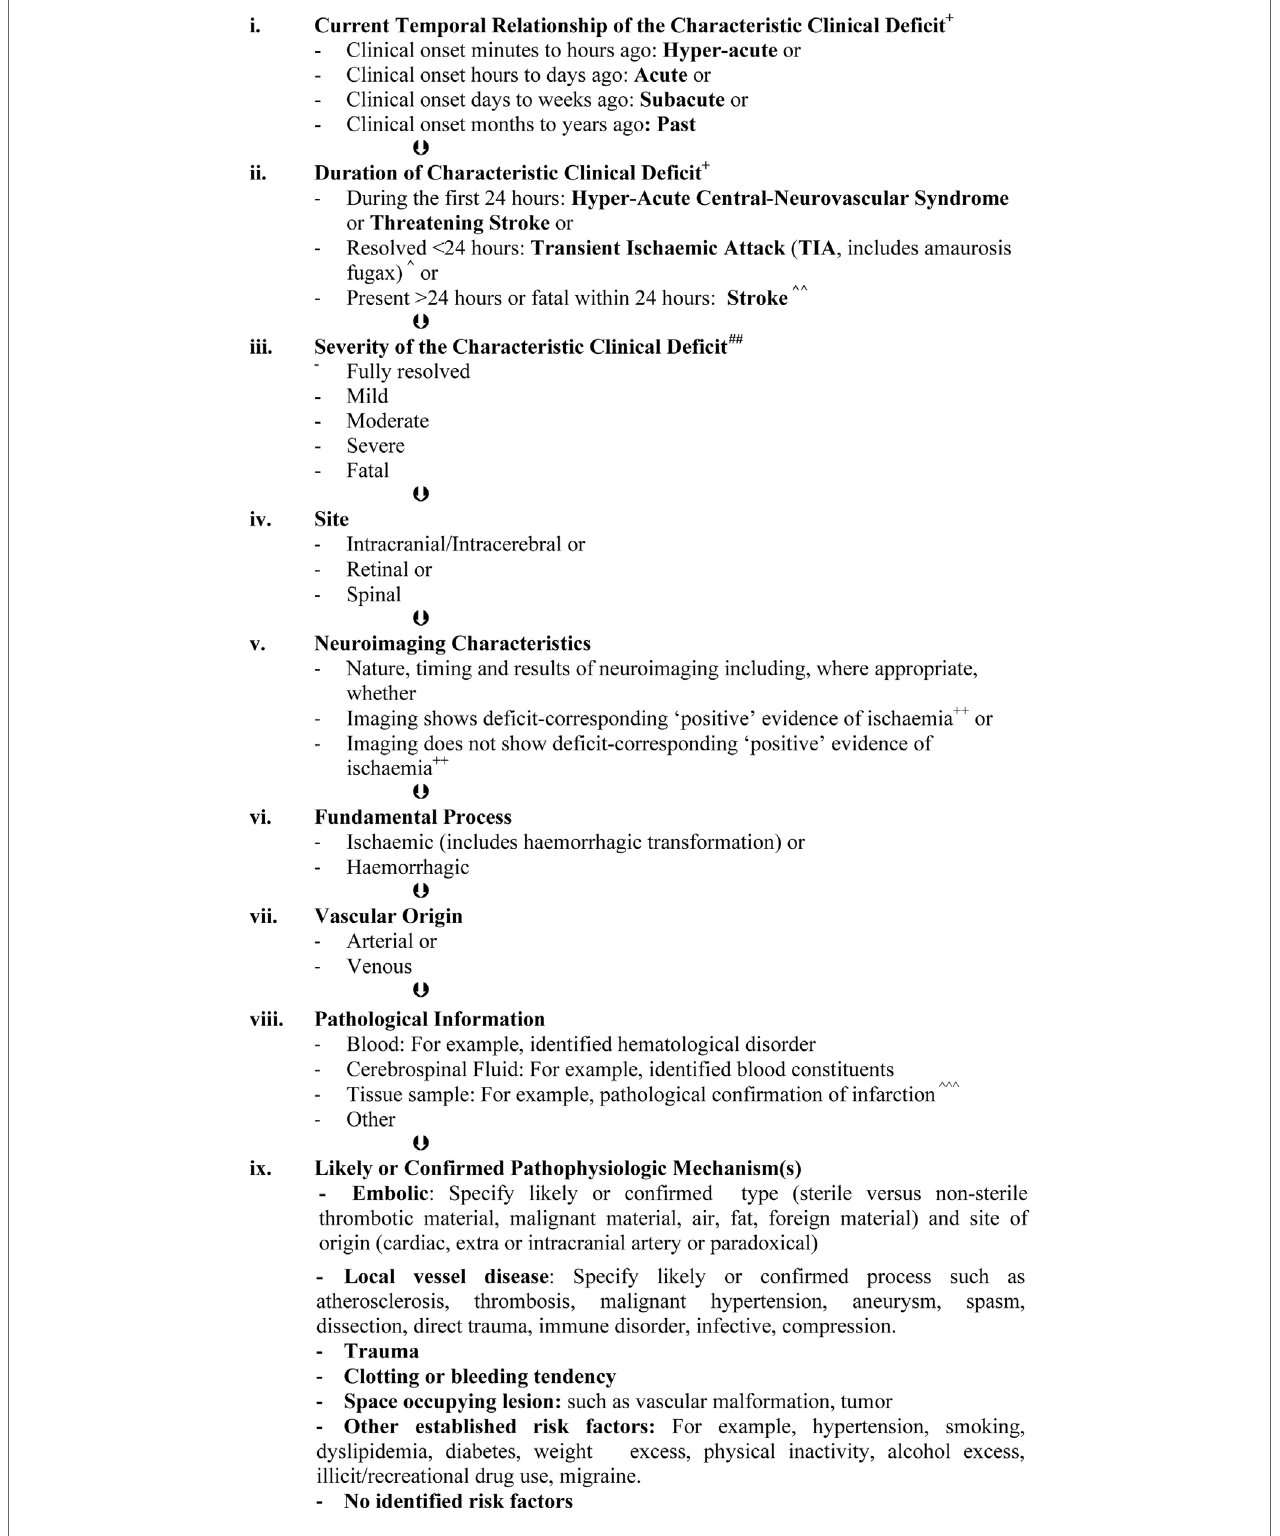
FiGUre 2 | diagnostic and classification framework for syndromes due to focal, intrinsic, central-neurovascular compromise* , ** ,#